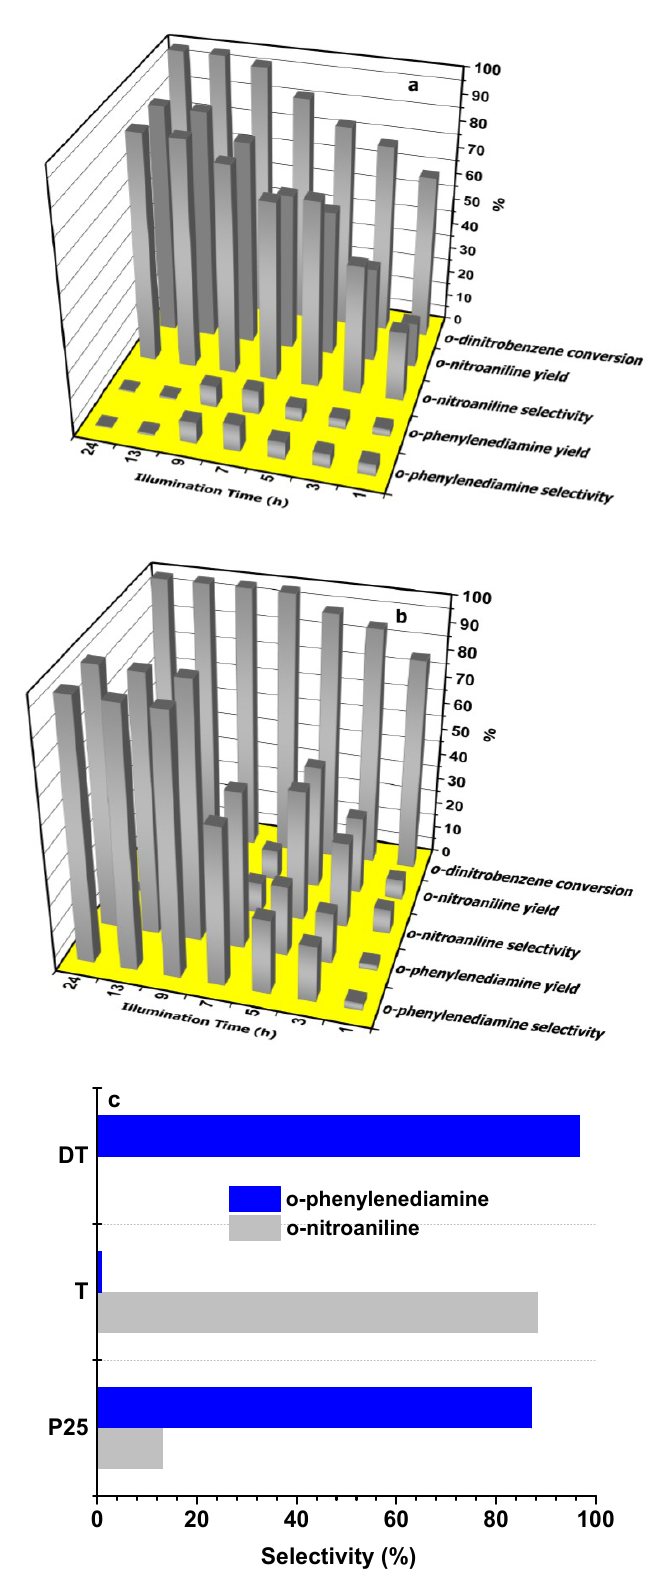
Figure 2. Yield and Selectivity for ( a ) T, ( b ) DT samples and ( c ) Selectivity for P25 compared with other samples, reaction conditions: 25 mg TiO 2 samples, 50 µ mol o-dinitrobenzene, 250 µ mol oxalic acid, 5 cm 3 deionized water,